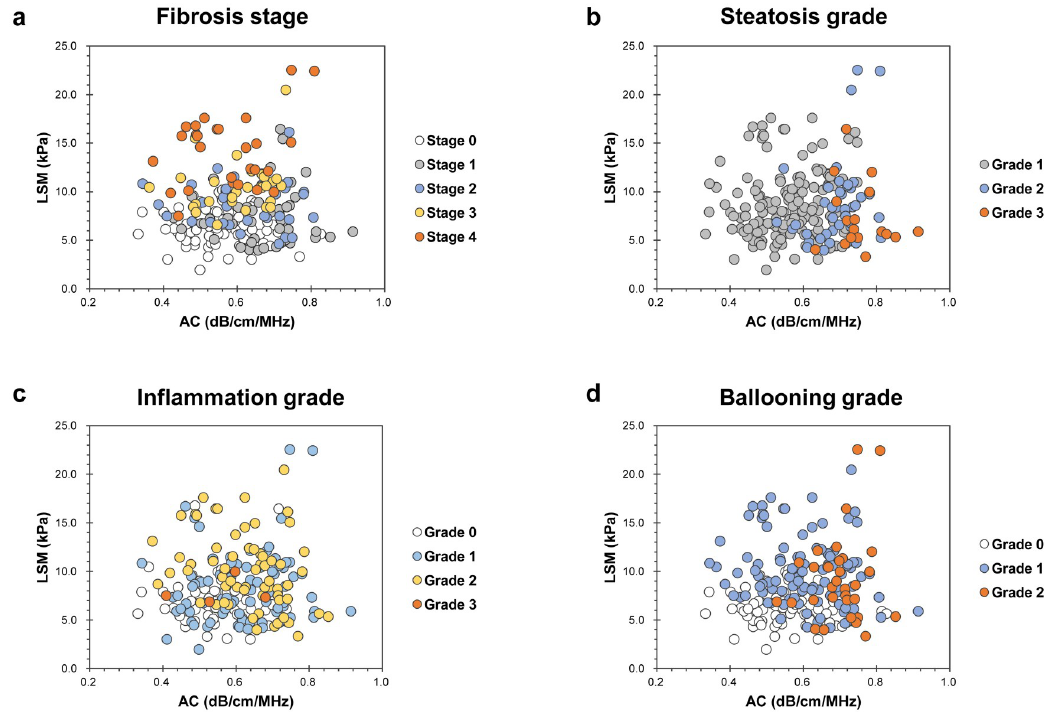
Fig 2. Patient distribution according to histopathologic evaluation, LSM, and AC. Fibrosis stage (a), steatosis grade (b), inflammation grade (c), and ballooning grade (d). LSM, liver stiffness measurement; AC, attenuation coefficient.